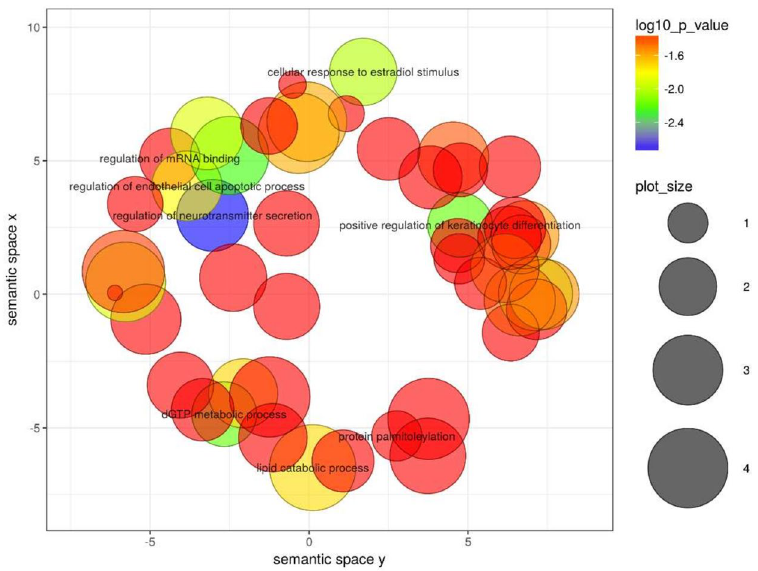
Figure 9. GO term results for dog specific seed family GGACCGA (orthogroup 490) as summarised by Revigo 62